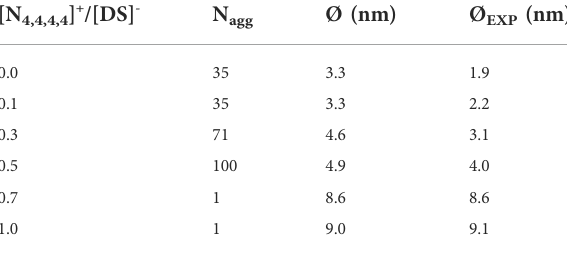
TABLE 1 Micelle size distribution obtained in the CG-MD simulations for 0.0, 0.1, 0.3 0.5, 0.7, and 1.0 [N 4,4,4,4 ] + /[DS] - ratios in the 2 wt% of SDS aqueous solution at 298 K. N agg and Ø are the averaged aggregation number and diameter of the aggregates, respectively, obtained throughout the last 0.5 μ s of simulation time.